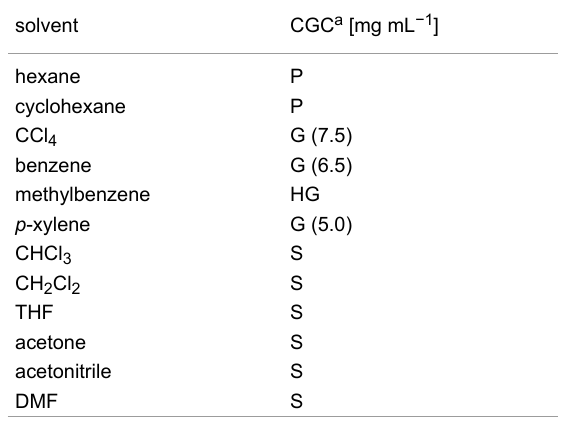
Table 1: Gelation ability of compound 3 in various organic solvents.